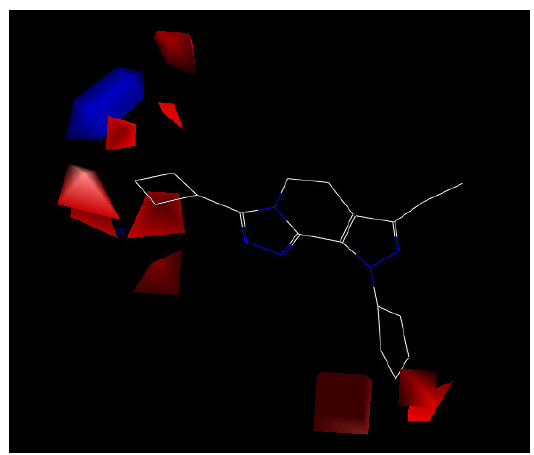
Figure 5. CoMFA contour map of the electrostatic field with compound 24.